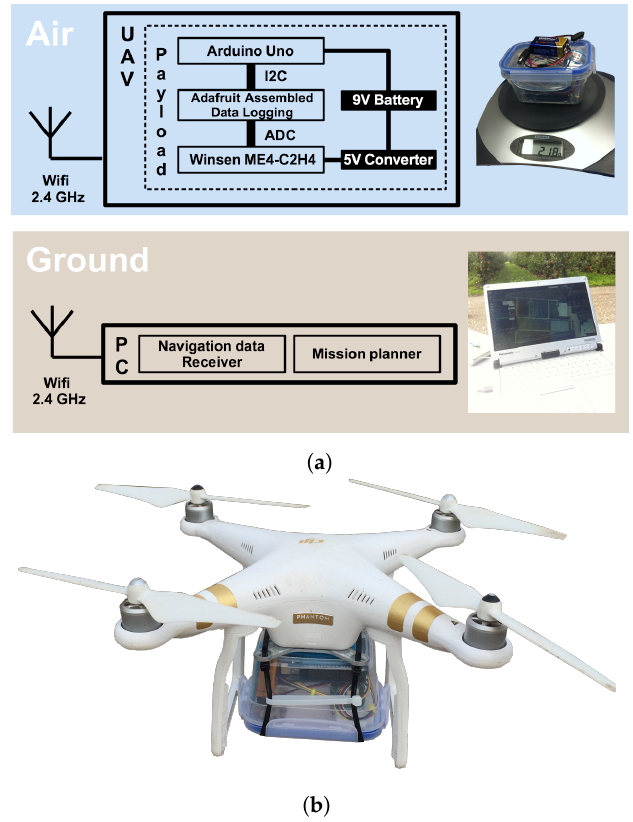
Figure 4. The ethylene flying-detector system: ( a ) air-ground system architecture and ( b ) Phantom 3 Professional (UAV) with the sensor prototype